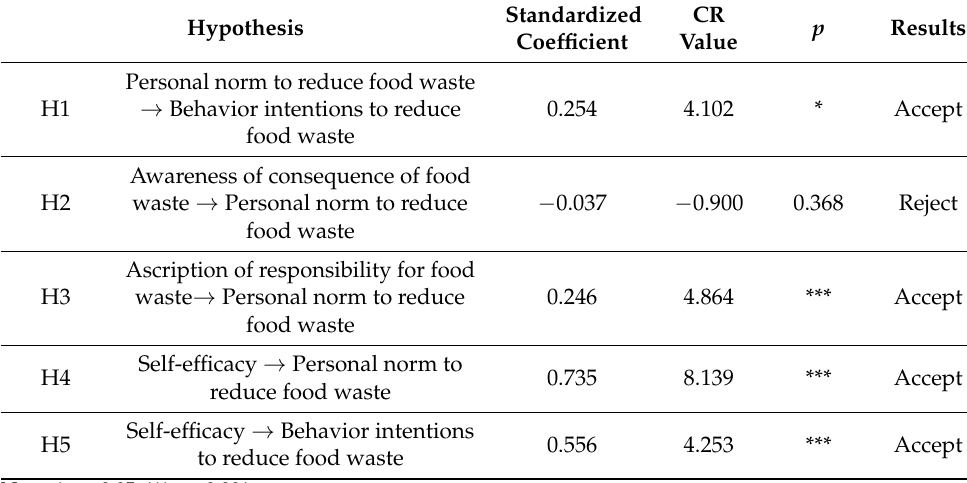
Table 5. Results of SEM model test.